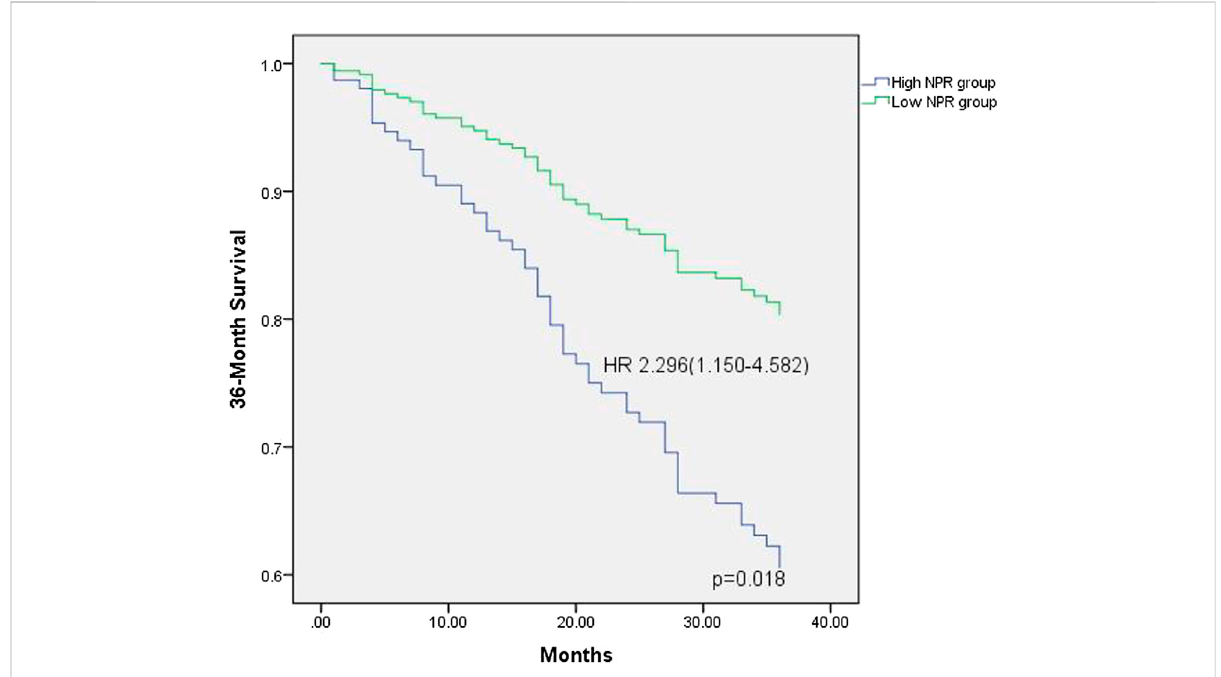
FIGURE 2 Thirty-six survival probability,strati fi edby NPRvalue,derived from multivariableCox regression analysis(variables inthemodel are described in Table 2). NPR: neutrophil to platelet ratio; HR: hazard ratio.